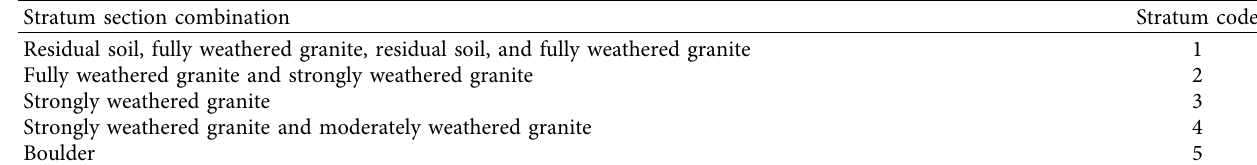
Table 3: Stratum section combination and corresponding stratum